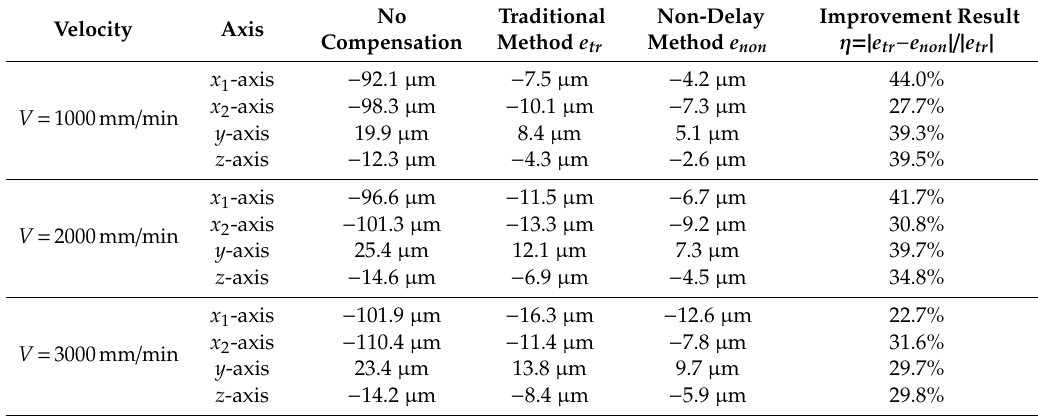
Table 9. Space motion error compensation